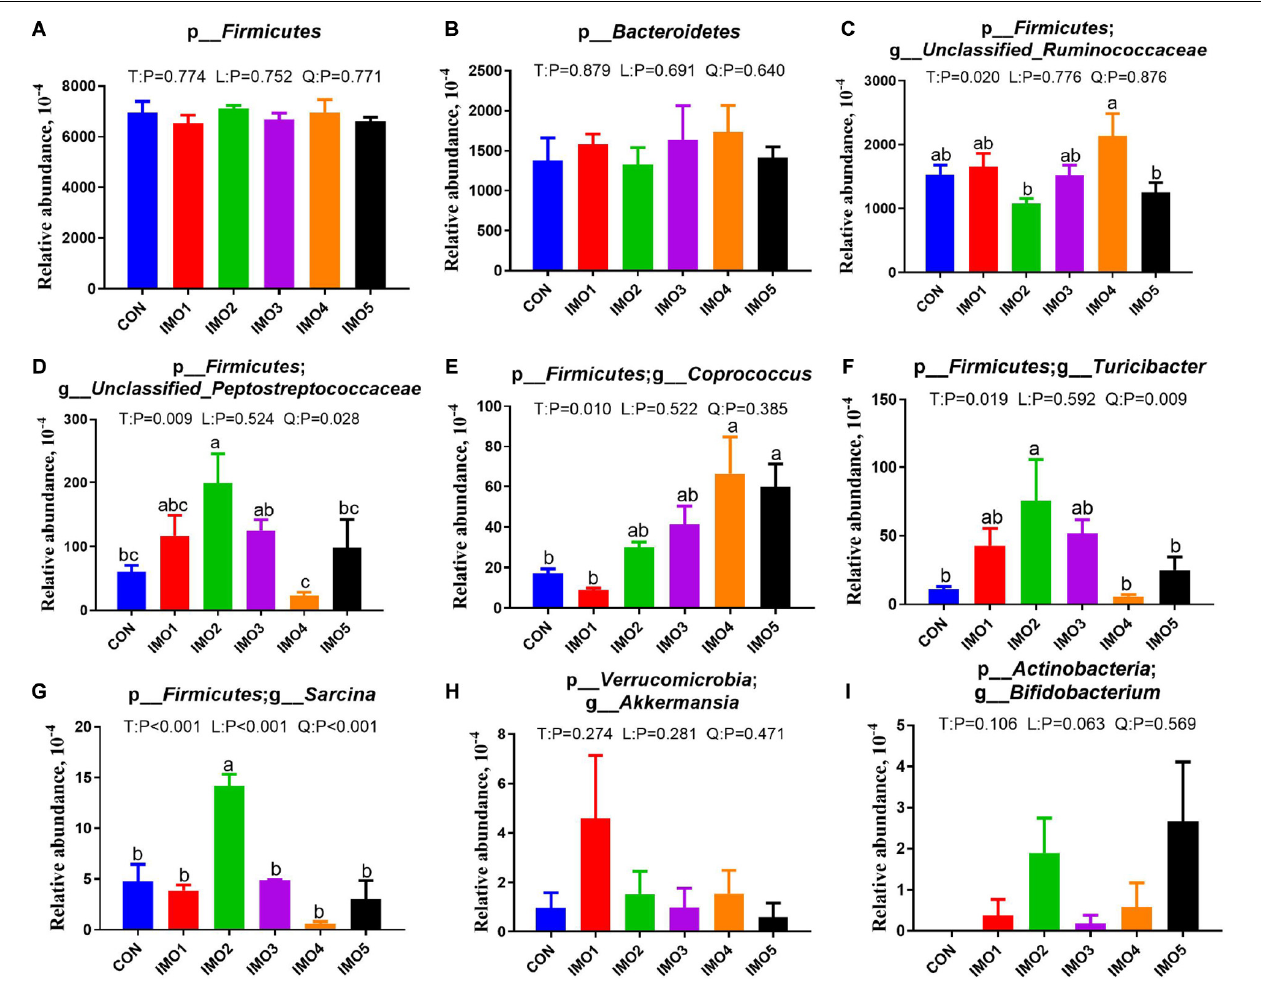
FIGURE 7 | Two major bacterial phyla and the changes in the seven distinct genera in gut microbiota composition of sows at day 10 of lactation. (A) p_ Firmicutes , (B) p_ Bacteroidetes , (C) p_ Firmicutes ; g_ Unclassified_Ruminococcaceae , (D) p_ Firmicutes ; g_ Unclassified_Peptostreptococcaceae , (E) p_ Firmicutes ; g_ Coprococcus , (F) p_ Firmicutes ; g_ Turicibacter , (G) p_ Firmicutes ; g_ Sarcina , (H) p_ Verrucomicrobia ; g_ Akkermansia , (I) p_ Actinobacteria ; g_ Bifidobacterium . Data are presented as means ± SEM ( n = 5). (a–c) Significant effect of treatment ( P < 0.05; values with different lowercase letters are significantly different; T, total; L, linear; Q,